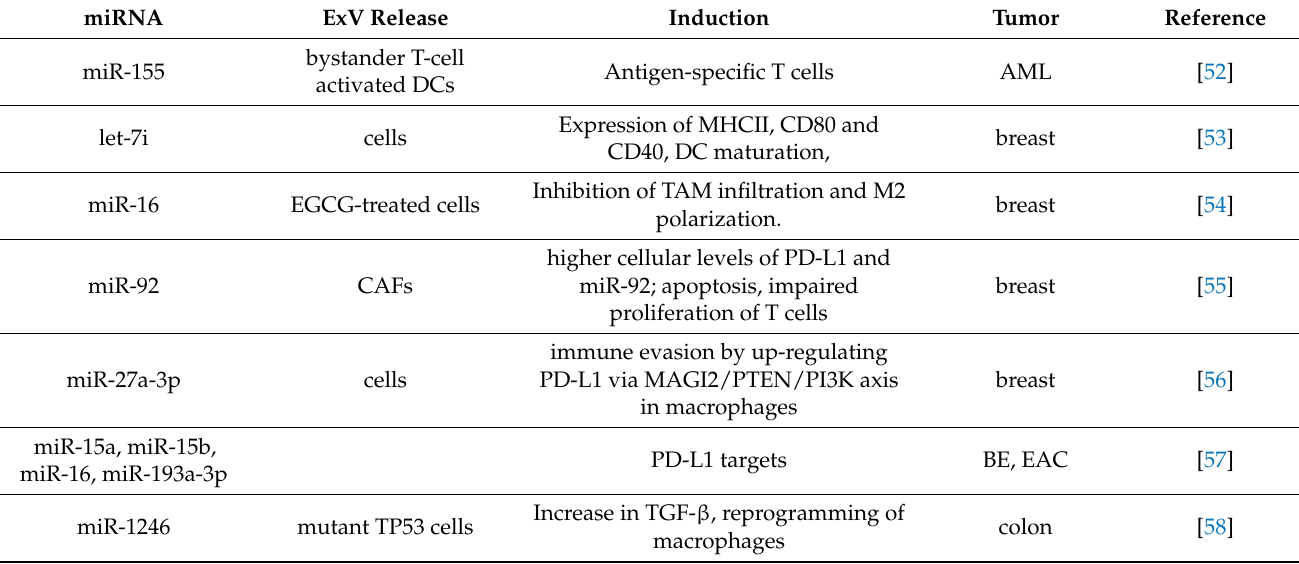
Table 1. ExVs carrying miRNAs, lncRNAs or PD-L1 in immune